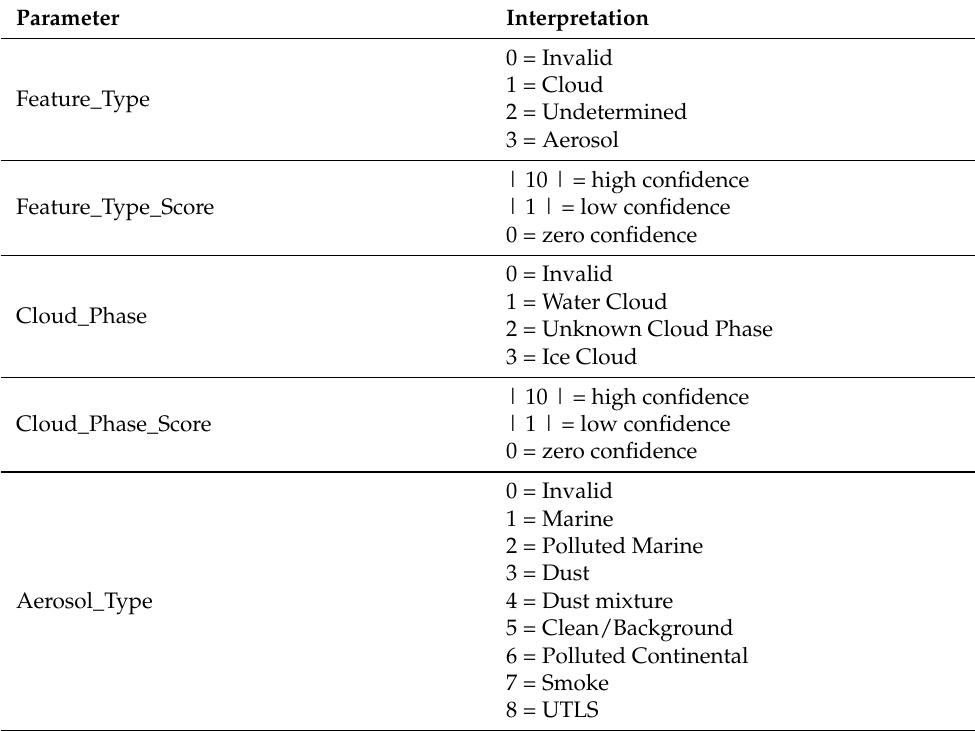
Figure 2. The CATS 1064 nm attenuated scattering ratio profile (black) from 24 August 2015 at 20:38:20 UTC (red line in Figure 1), averaged to 5 km horizontally. The CATS layer detection algorithm uses a threshold profile (red) to detect features, which in this case, identified four distinct layers (pink, brown, teal, and blue) with scattering ratio values greater than the threshold profile. Table 1. Interpretations of the Vertical Feature Mask (VFM) parameter values found in the CATS L2O data